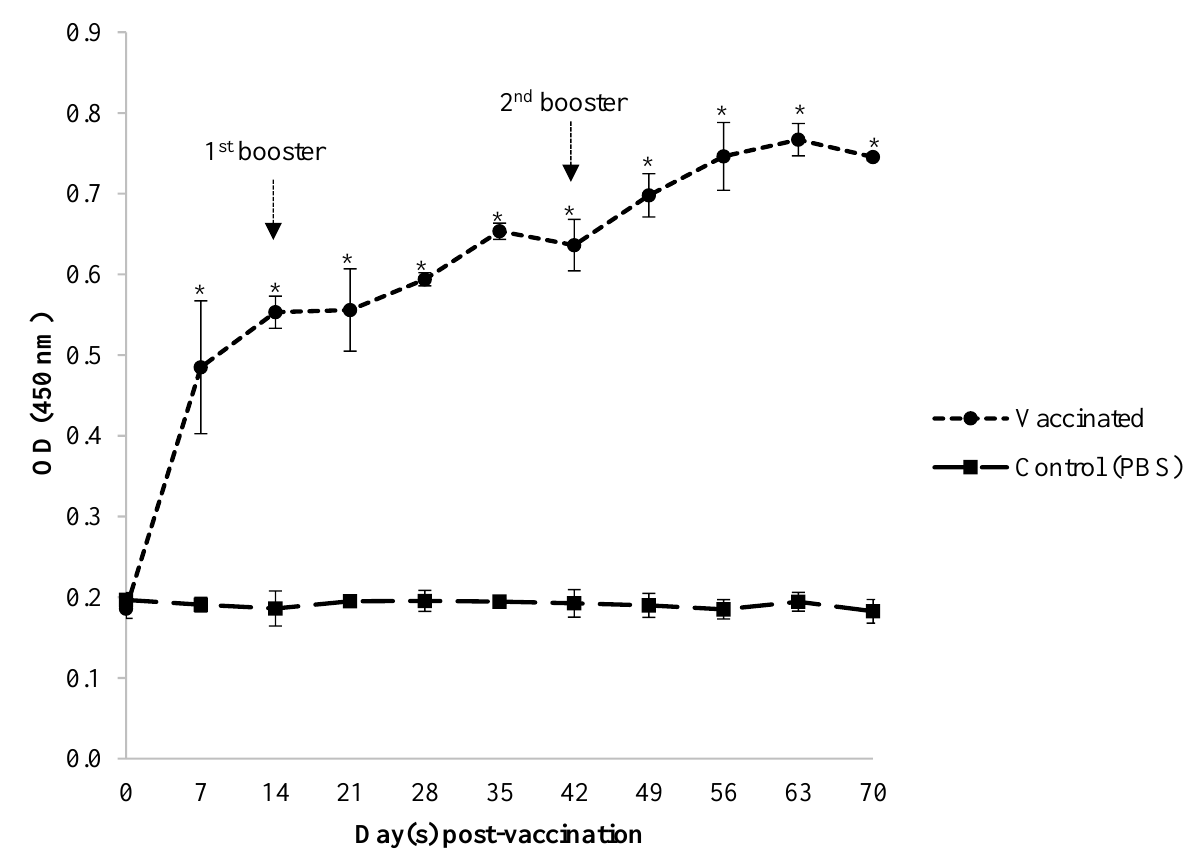
Figure 3. Antibody level of specific IgM in serum against Vibrio parahaemolyticus strain VPK1 in Asian seabass, Lates calcarifer following oral vaccination with Vibrio harveyi strain VH1. Data are the mean ± SD from 6 fish per group at each time point. Asterisks stand for statistically significant differences ( p < 0.05) between